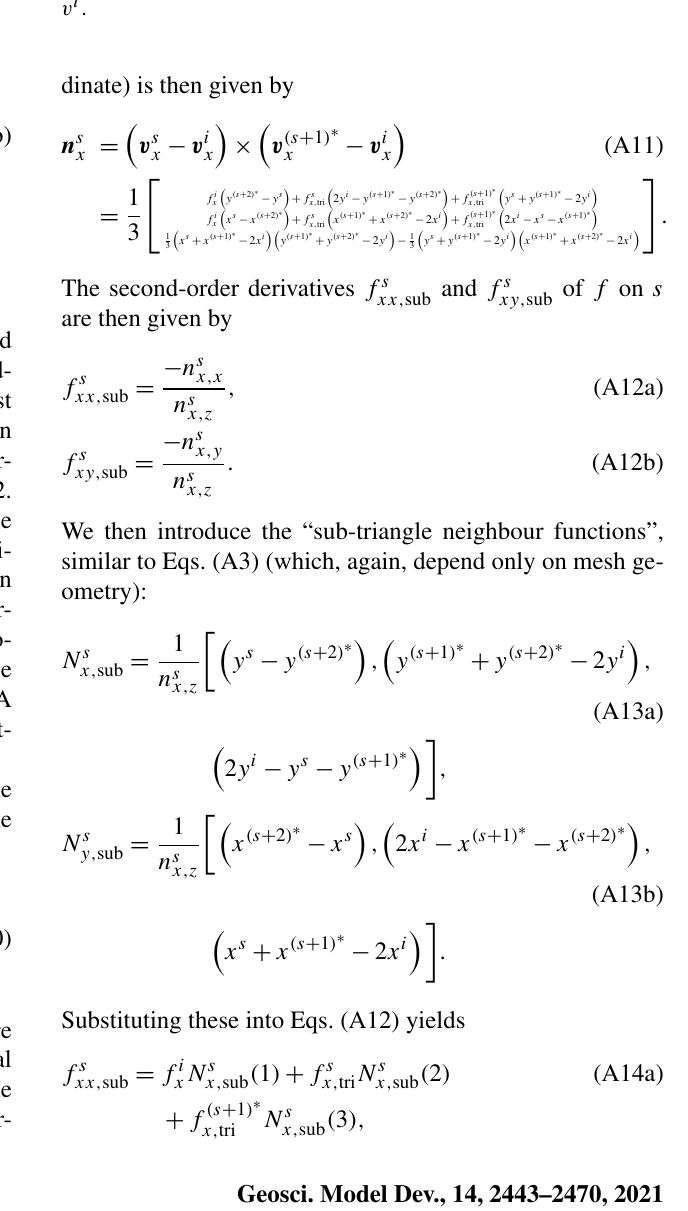
Figure A2. The geometric centres of the triangles surrounding ver- tex v i make up the vertices of a new set of “sub-triangles”, which can be used to define the second derivative of a function on vertex v i